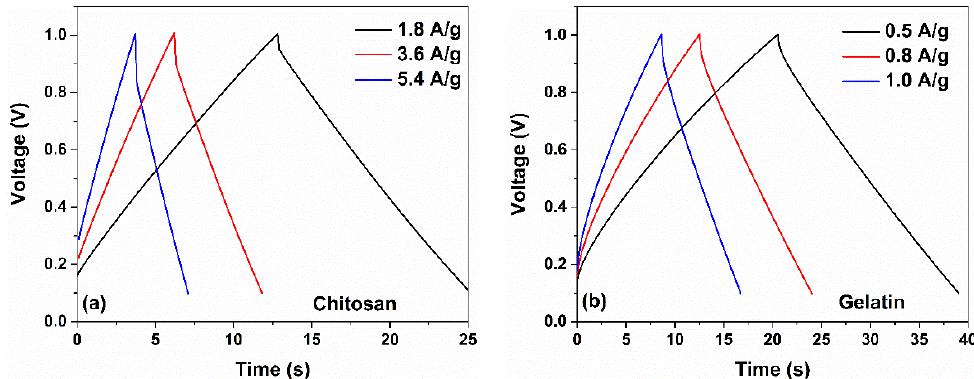
Figure 5. Galvanostatic charge and discharge curves at various current densities for the ( a ) chitosan and ( b ) gelatin-based supercapacitors in 1 M NaCl electrolytes, respectively.